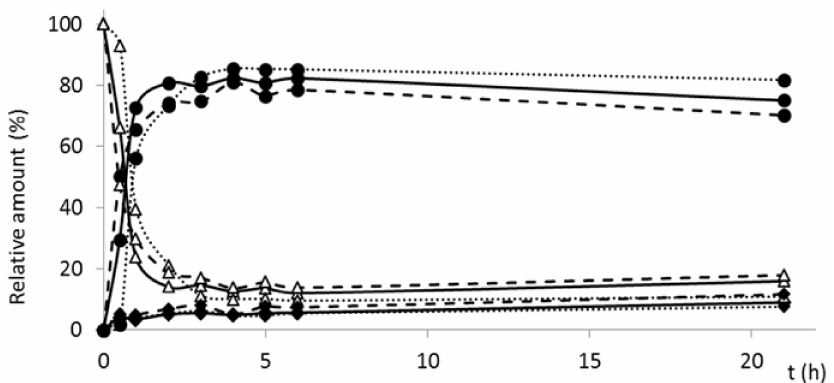
Figure 3. Time-course of silychristin sulfation by AST from D. hafniense . The reaction mixtures were incubated with the enzyme and p -NPS as sulfate donor separately under Ar (solid line), in low oxygen environment (dashed), and under 100% O 2 (dotted line) as described in the Experimental. Relative content of silychristin ( (cid:52) ), silychristin-19- O -sulfate ( ), and 2,3-dehydrosilychristin-19- O -sulfate ( (cid:7) ) was determined from the AUC% from the respective HPLC chromatograms using the calibration curves of silychristin and